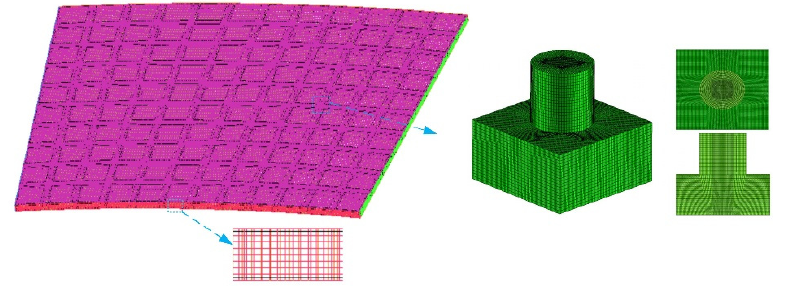
Figure 7. Boundary condition of flow field.